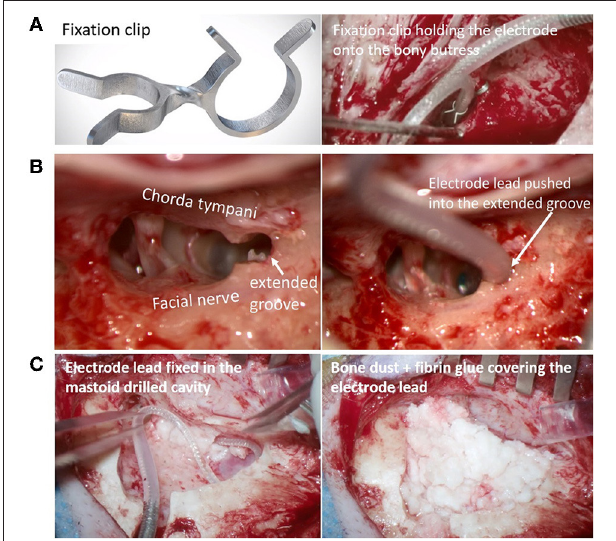
FIGURE 6 | Fixation clip holding the electrode lead onto the bony-buttress of the middle ear space [ (A) Image courtesy of Joachim Müller, Munich, Germany]. Electrode lead pushed into the extended groove between the facial nerve and chorda tympani [ (B) Image courtesy of Timo Stöver, Frankfurt, Germany]. The electrode lead is fixed in the posterior tympanotomy [ (C) -left] and the excess electrode lead coil within the undercut cortex is covered with bone dust mixed with fibrin glue [ (C) -right- Image courtesy of Paul Van de Heyning, Antwerp,